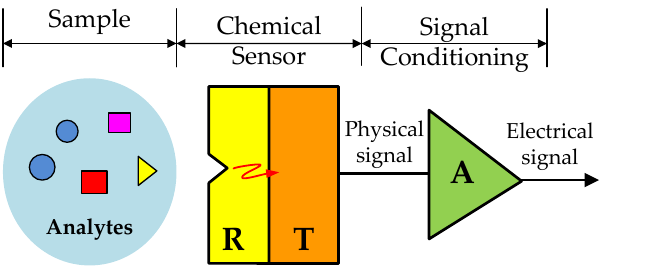
Figure 5. Basic constitution of a (bio)chemical sensor sensitive to a specific analyte: R = receptor (molecular recognition element); T = transducer; A = amplifier.